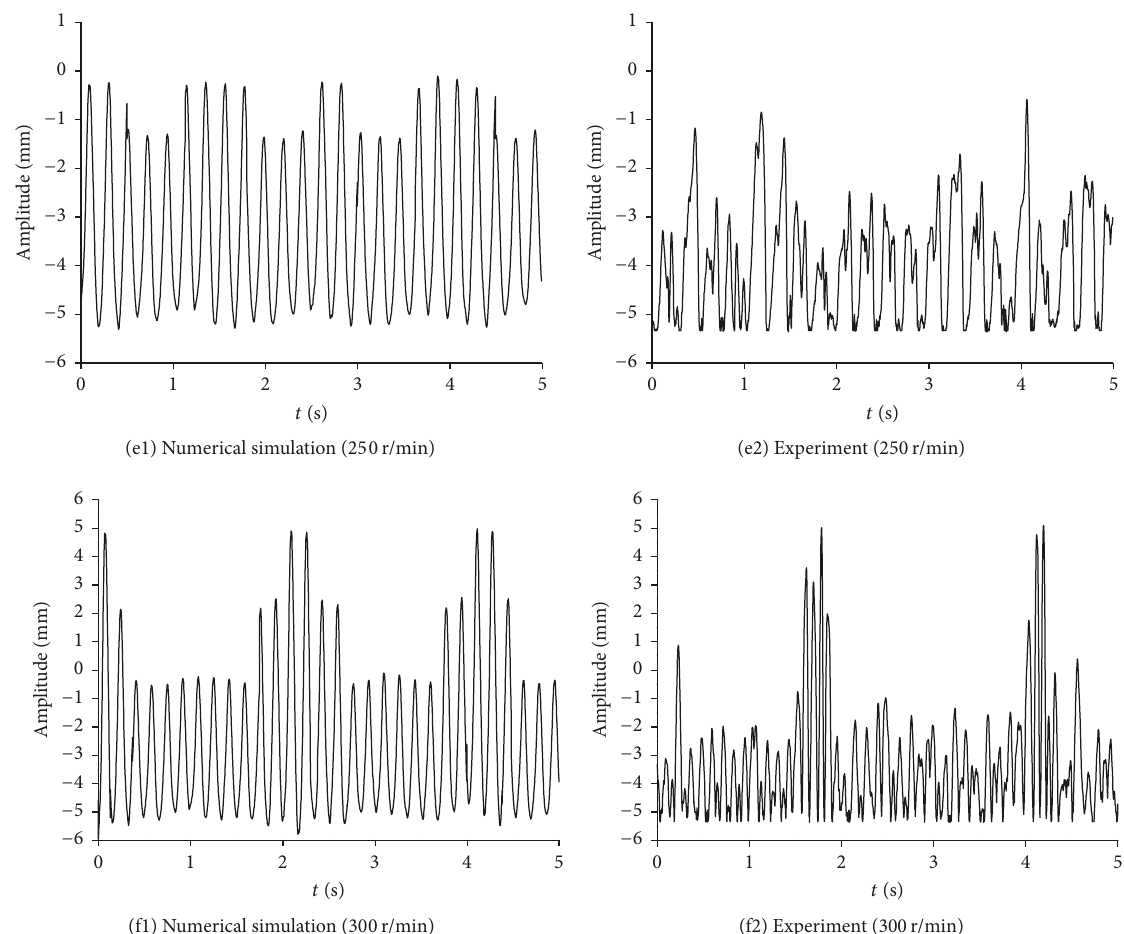
Figure 11: Dynamic buckling with different